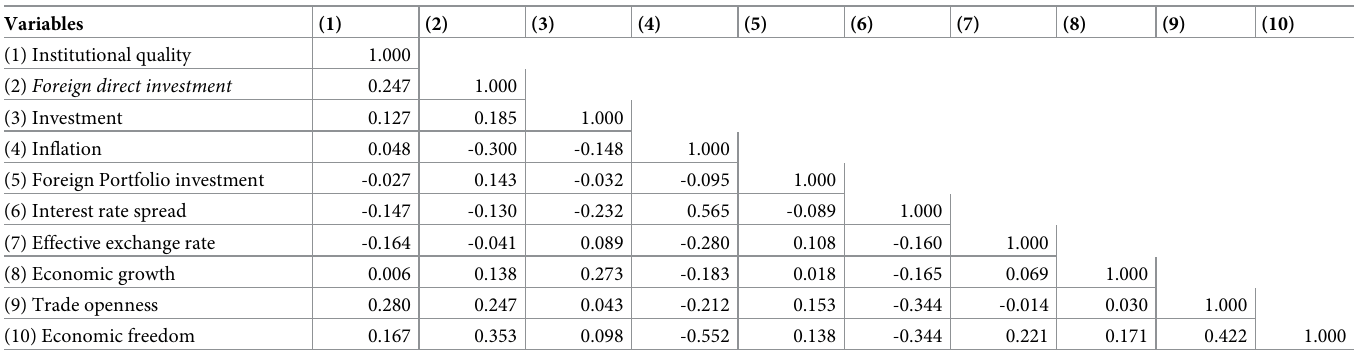
Table 2. Matrix of